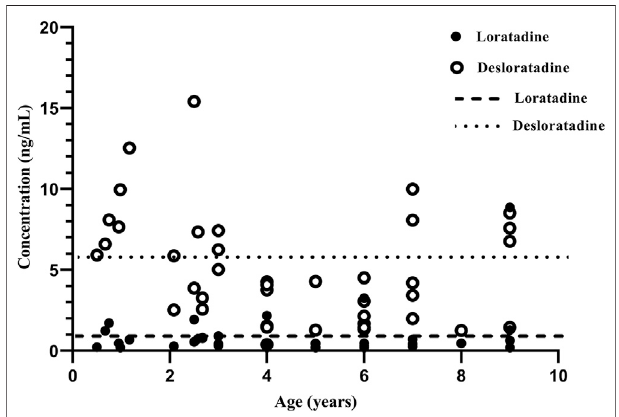
FIGURE2| Therelationshipbetweenplasmaconcentrationvs.age.The long dotted line is the mean trough plasma concentration of loratadine in steady-state condition in adults. The short dash line is the mean trough plasma concentration of desloratadine in steady-state condition in